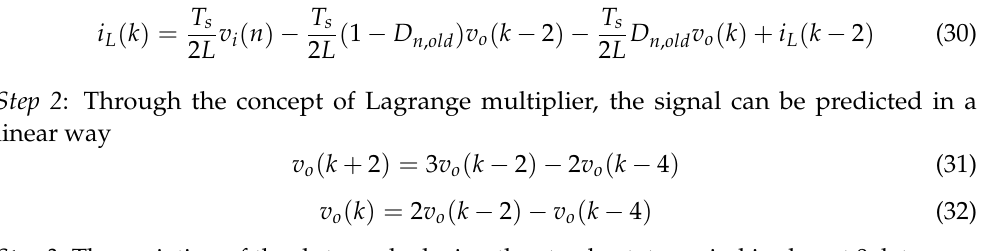
Figure 16. Predictive controller signal waveform ( a ) Digital controller built-in counter ( b ) Command current and feedback current.